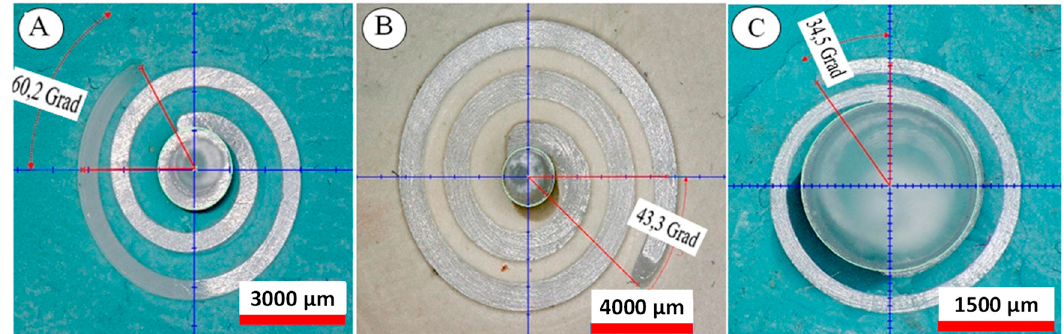
Figure 4. Example of measurements of the angle α for three different spiral parts with cross sections of ( A ) 0.5 × 0.5 mm 2 , flow length: 28.83 mm; ( B ) 1 × 1 mm 2 , flow length: 62.86 mm and ( C ) 0.25 × 0.25 mm 2 , flow length: 11.21 mm.